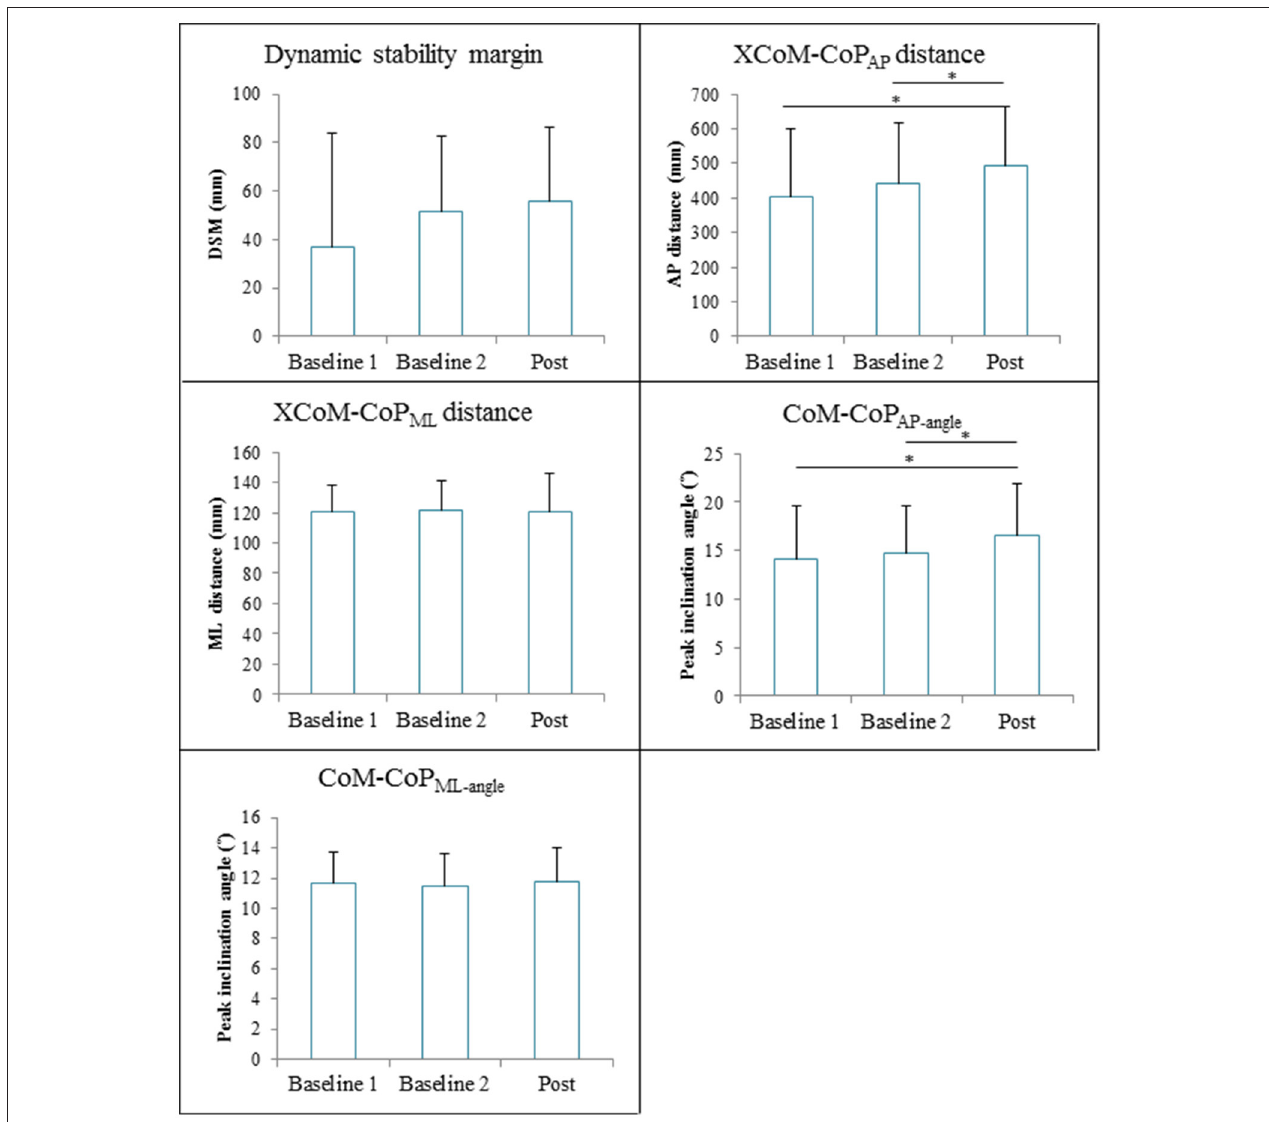
FIGURE 7 | Gait stability (means and standard deviations) during 6 weeks GRAIL training. A visual representation of the gait stability measures is given in Figure 4 . *Asterisk indicates a post-hoc significant difference ( α =